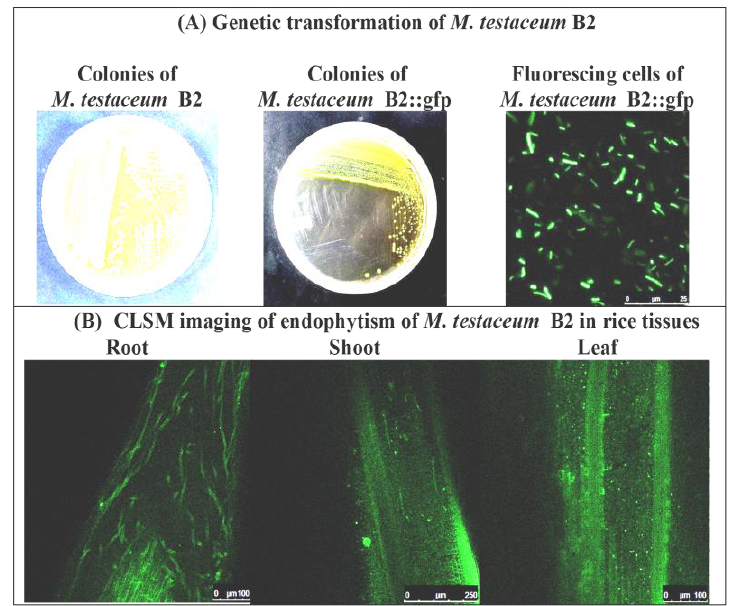
Figure 3. Endophytism of Microbacterium testaceum B2::gfp in rice plants as revealed by confocal laser scanning microscopy.( A ) Genetic transformation of M. testaceum B2 using Tn7-based neutral integration of gfp gene. (Images from left to right: Intrinsic rifamycin resistant colonies on NA+Rif50 plate, gfp transformed colonies on NA+Rif50+Gm20 plate, pure culture cells of transformed M. testaceum B2::gfp).( B ) CLSM imaging of endophytically colonized M. testaceum B2::gfp.